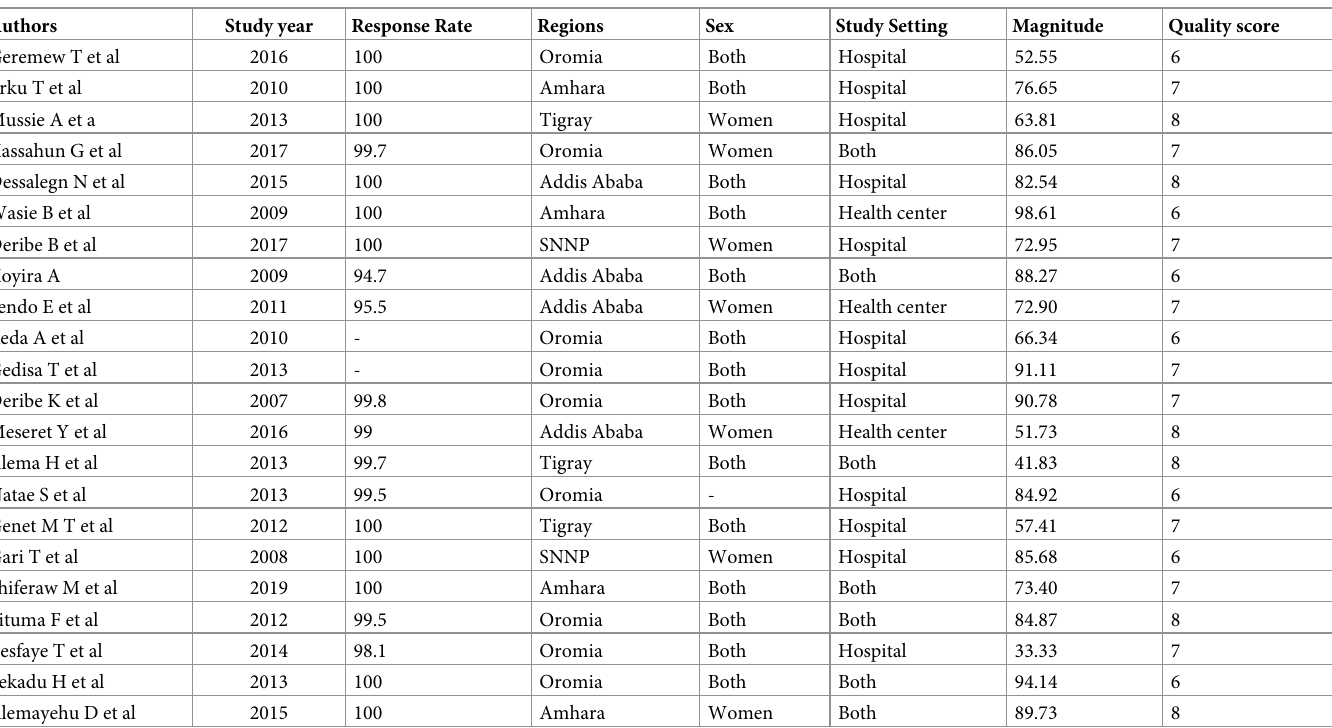
Table 1. Characteristics of studies included in systematic review and